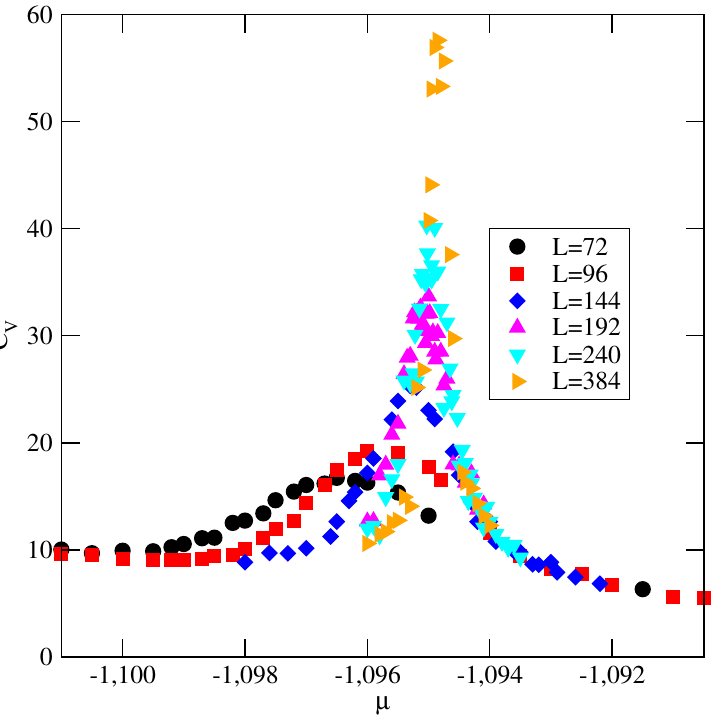
Figure 7. The heat capacity curves for the system with u ∗ = − 0.05 at T = 0.15, recorded using the simulation cells of different sizes (shown in the